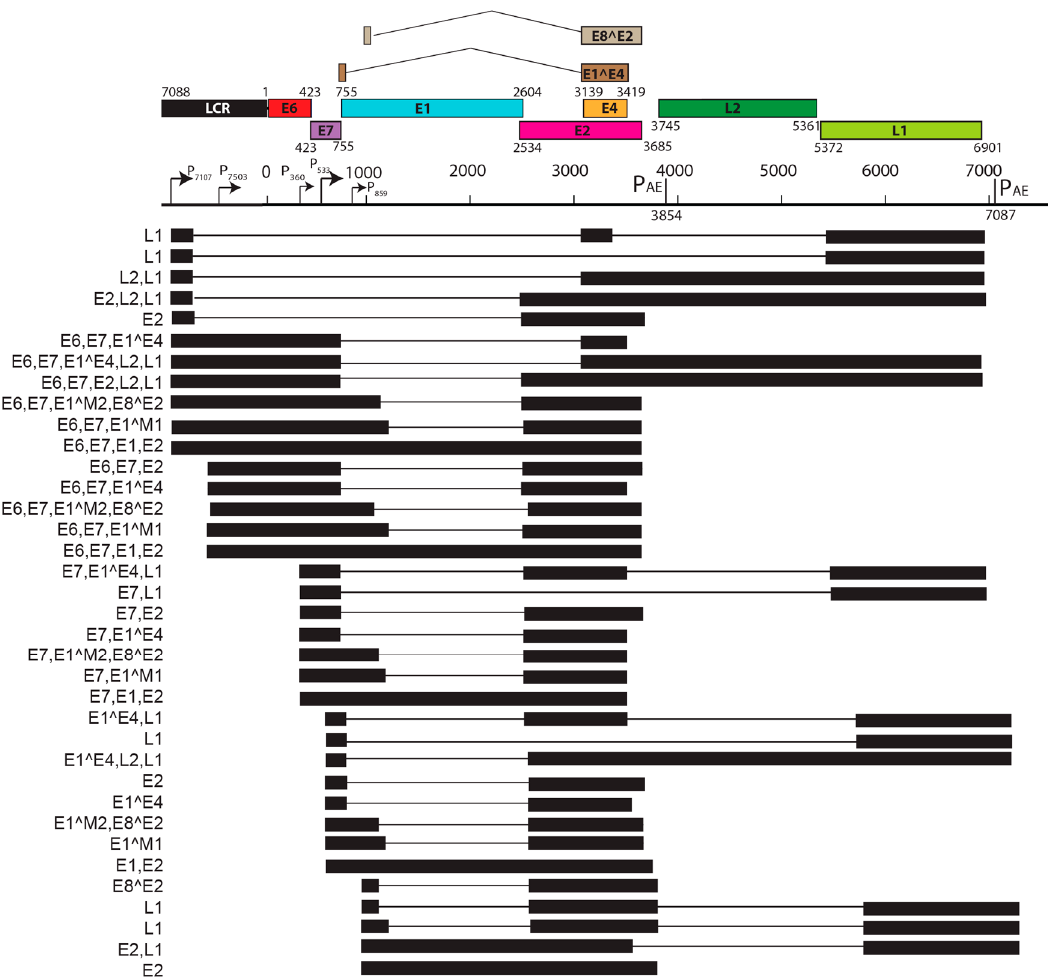
Figure 5. Transcription map of MmuPV1. This figure has been modified and adapted from Xue, et al. (2017) (Manuscript accepted [102]) The bracket line in the middle of the panel represents a linear form of the virus genome for better presentation of head-to-tail junction, promoters (arrows), and polyadenylation cleavage sites, early pA CS 3864 and late pA CS7063. The open reading frames (ORFs) are diagramed above the bracket line as colored boxes, and the numbers above each ORF are nucleotide positions of the first nucleotide of the start codon and the last nucleotide of the stop codons in the MmuPV1 genome. LCR indicates a long control region. Below the bracket line are the RNA species derived from alternative promoter usage and alternative RNA splicing. Exons (black boxes) and introns (thin lines) are illustrated for each species of the RNA, with the mapped splice site positions numbered by nucleotide position in the virus genome and coding potentials are shown on the left.